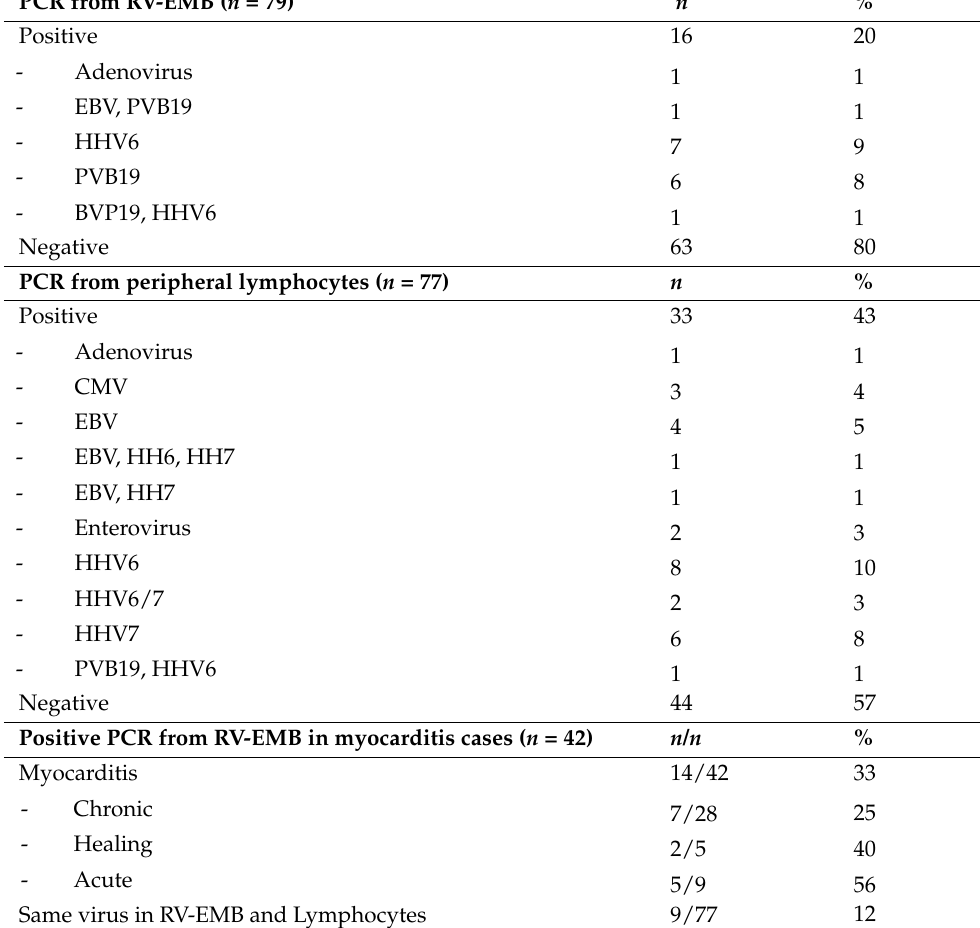
Table 3. Molecular biological detection of cardiotropic viruses performed by nested PCR from right ventricular endomyocardial biopsy (RV-EMB) and peripheral lymphocytes. Only in 9 RV-EMB the same pathogen was found in the myocardium as well as in the lymphocytes. Regarding the relationship between histological finding of myocarditis and viral detection only 33% the RV-EMB were positive for